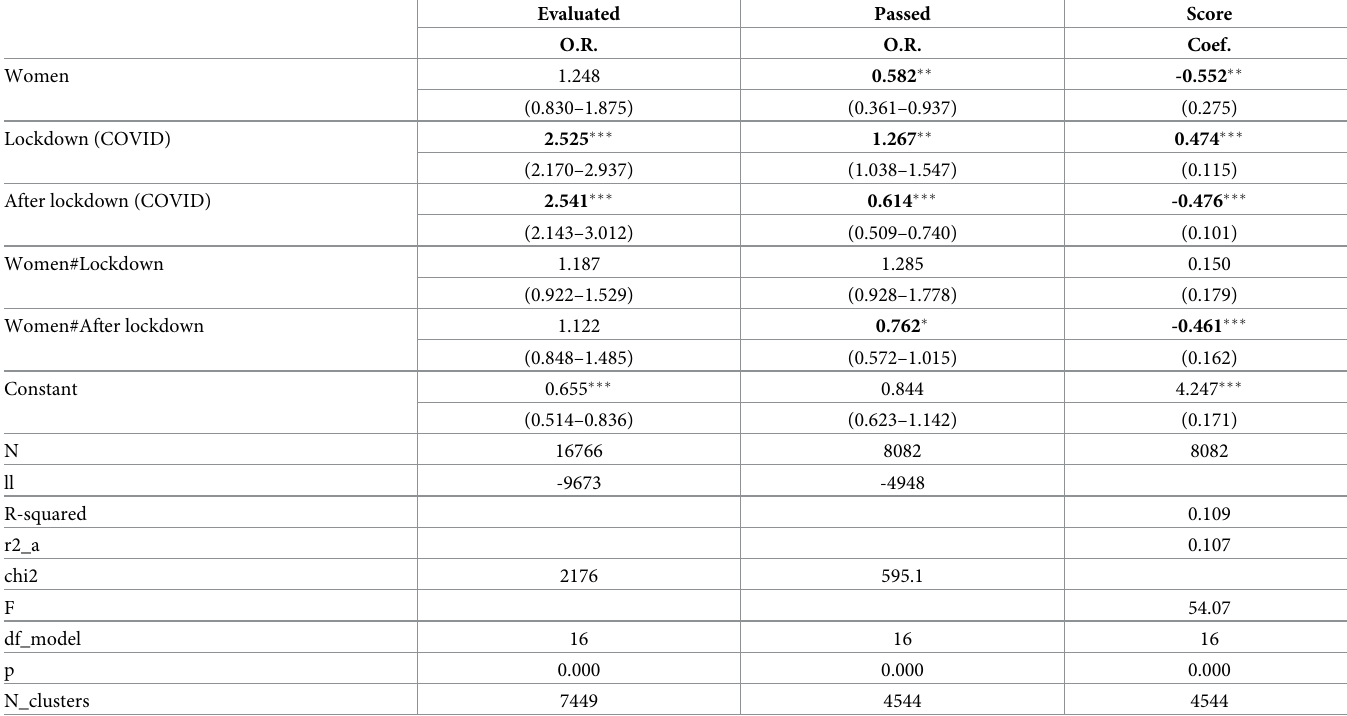
Table 10. Selected estimation results in the whole model with interactions. COVID-19 and sex